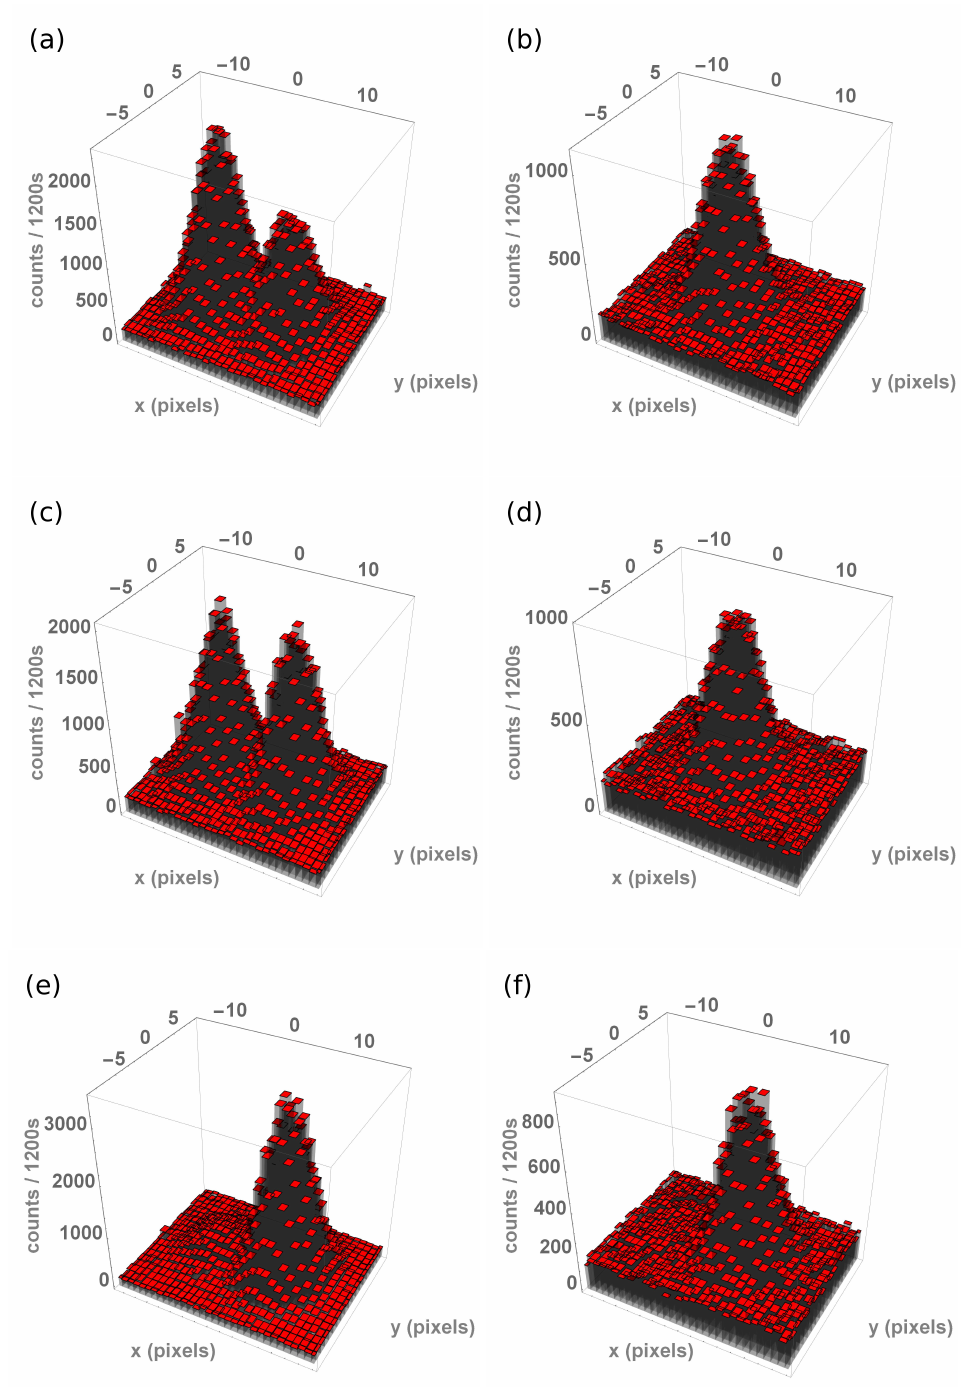
Figure 4. Plots of the photon counts distributions obtained with projective ( a , c , d ) and protective ( b , d , f ) measurements, for three different linearly polarized initial states | ψ θ (cid:105) . ( a , b ) (cid:12) (cid:69) (cid:12) ≈ 0.924 | H (cid:105) + 0.383 | V (cid:105) ( e , f ) (cid:12) ψ π 8